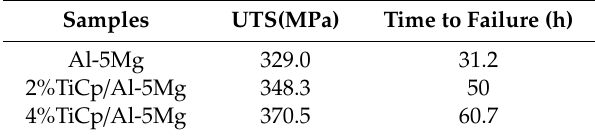
Figure 10. Stress–strain curves of the weld with and without TiC particles during slow strain rate testing (SSRT) in 3.5 wt% NaCl solution. Table 2. The ultimate tensile strength (UTS) and time to failure of the welds.